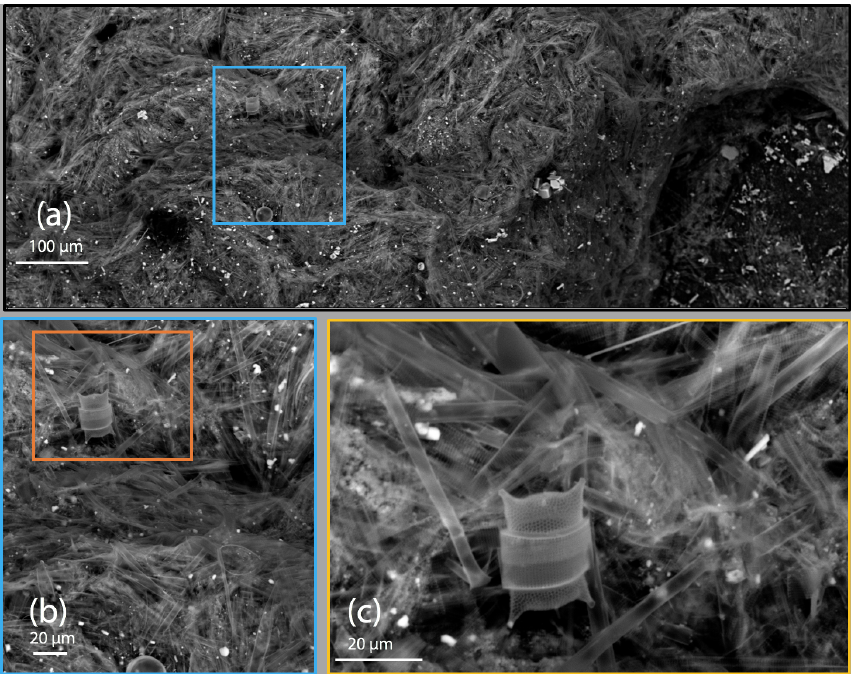
Figure A6. Scanning electron microscope imagery of an anchovy faecal pellet captured by CFE-Cal at location L1 (see Fig. 14 – L1-125m). Shown are secondary electron images of the pellet at (a) 244 × , (b) 925 × , and (c) 2500 × magnification. The contents of the pellet are dominated by diatom frustules indicating that anchovies were primary grazers at this